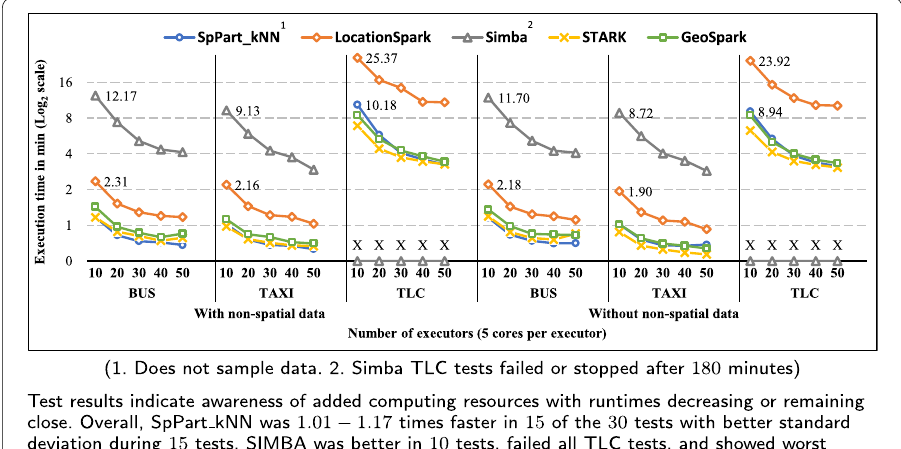
Fig. 13 Cost of building the partitioner with and without non-spatial